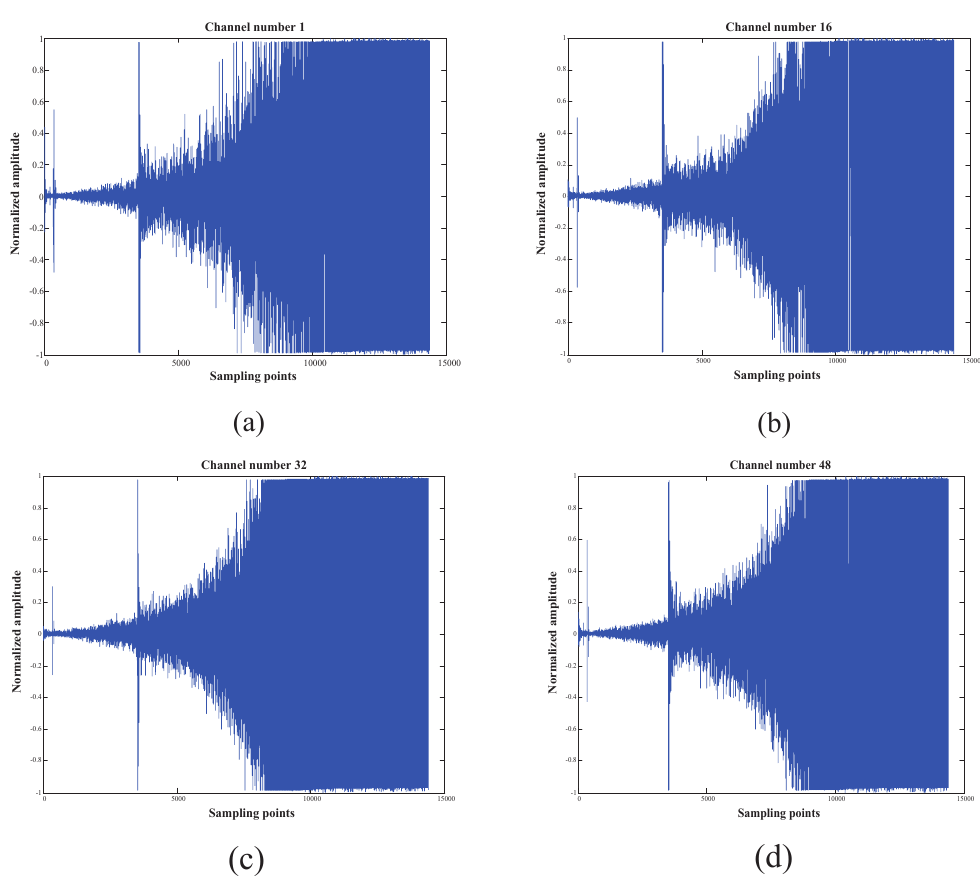
Figure 8. The raw echo signals in different channels: ( a ) Channel 1; ( b ) Channel 16; ( c ) Channel 32; ( d ) Channel 48.